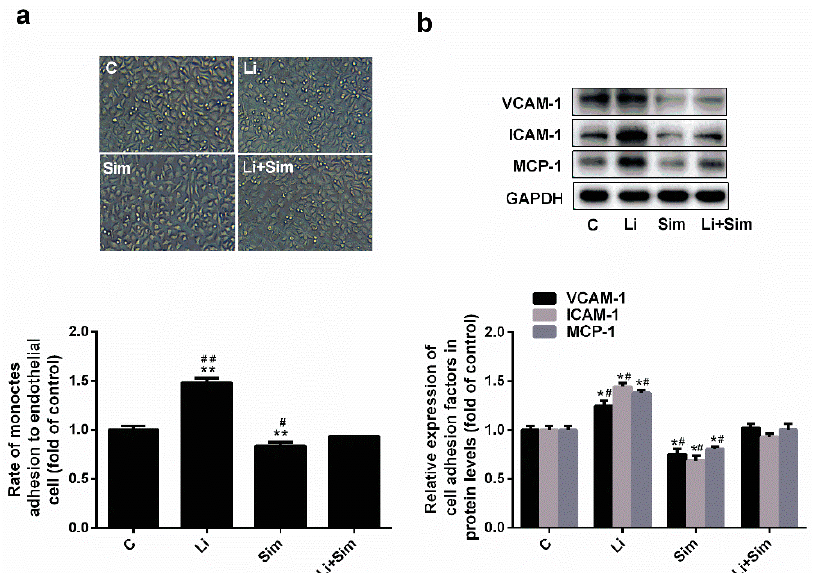
Figure 3. Simvastatin reduces the adhesion ability of HUVECs by inhibiting the Wnt/ β -catenin pathway. ( a ) Adhesion rate of each group ( b ) Expressions of adhesion molecules in protein level. * p < 0.05 or ** p < 0.001 versus C group; # p < 0.05 or ## p < 0.001 versus Li+Sim group, n = 3. C, HUVECs treated with H 2 O 2 ; Li, C group treated with LiCl; Sim, C group treated with simvastatin, Li+Sim, C group treated with simvastatin and LiCl.